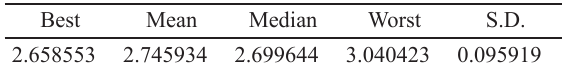
Table 9. Statistical results of the KH optimization runs executed for the helical spring